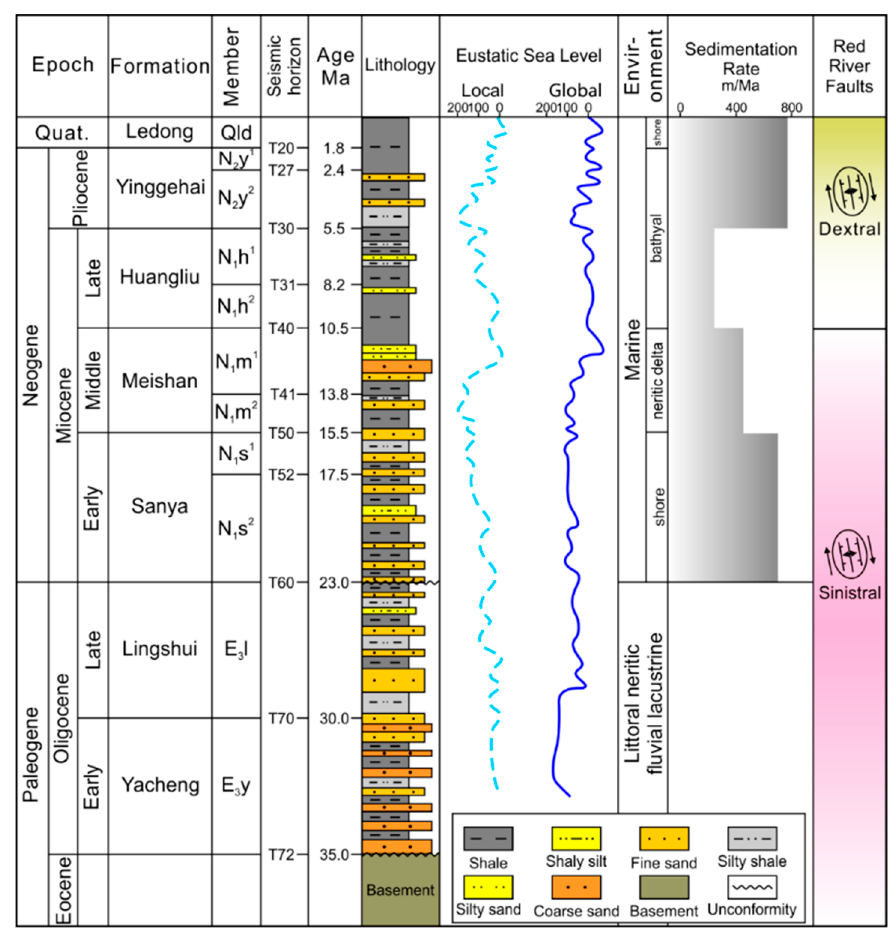
Figure 2. The stratigraphic profile of the Yinggehai Basin (from [29] Li et al.,